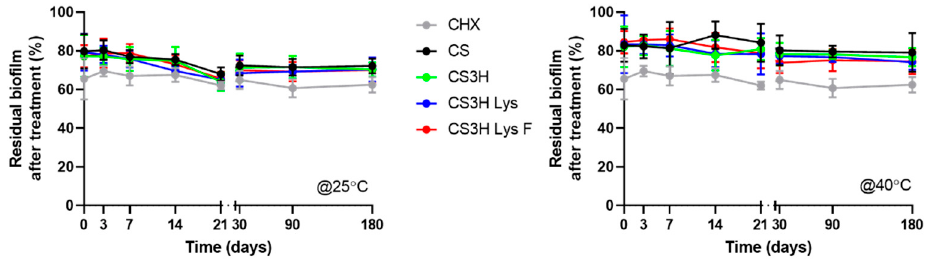
Figure 6. Effect of mouthwashes stored at 25 and 40 °C for up to 6 months on S. mutans biofilm formation. Data are reported as mean ± SD, n = 9. Two-way ANOVA: polymer effect p < 0.0001, time effect p < 0.0001, polymer and time p > 0.05.